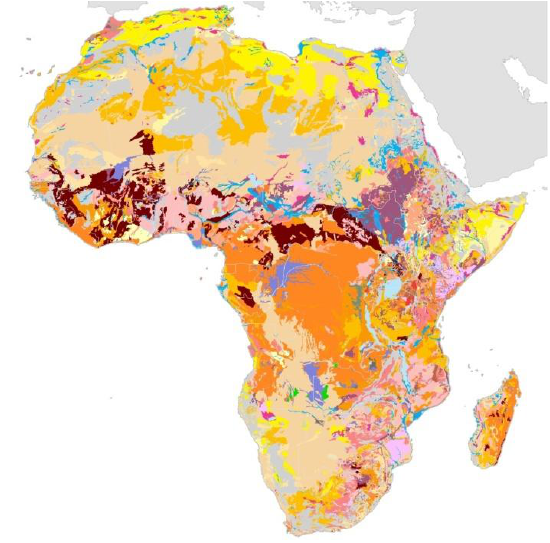
Figure 1. Map of Africa depicting different types of soil. Adapted from European Soil Portal—Soil Data and Information Systems